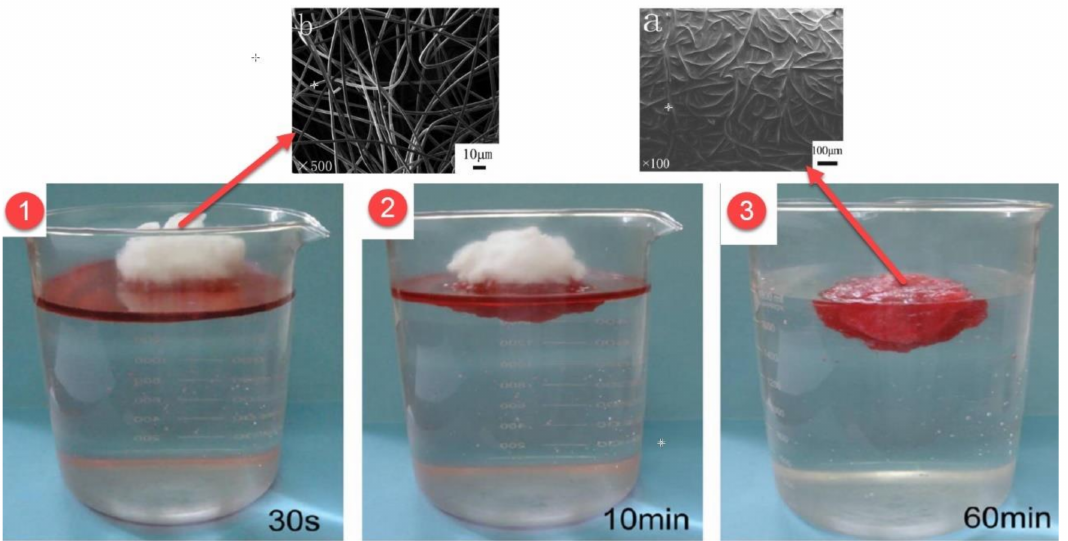
Figure 8. Experiment separation of motor oil on the water and SEM images: ( a )—SEM image of PVC/PS sorbent after sorption of motor oil; ( b )—SEM image of PVC/PS sorbent; ( 1 )—after 30 s sorp-tion; ( 2 )— after 10 min sorption; ( 3 )—after 60 min